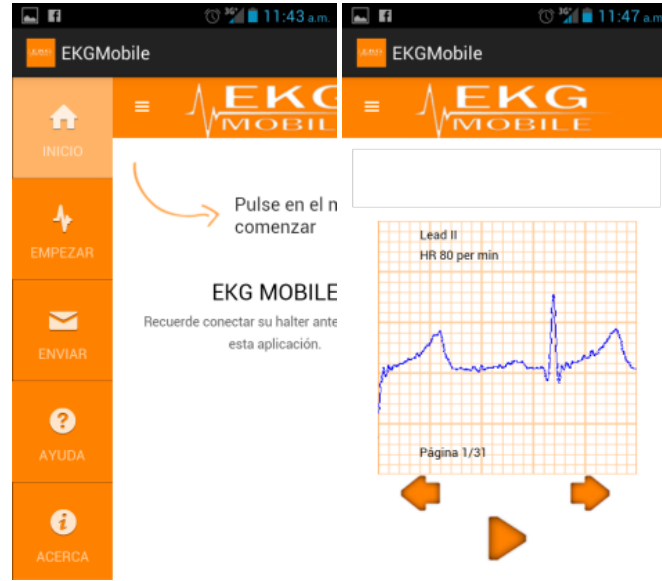
Figure 12. ECG mobile